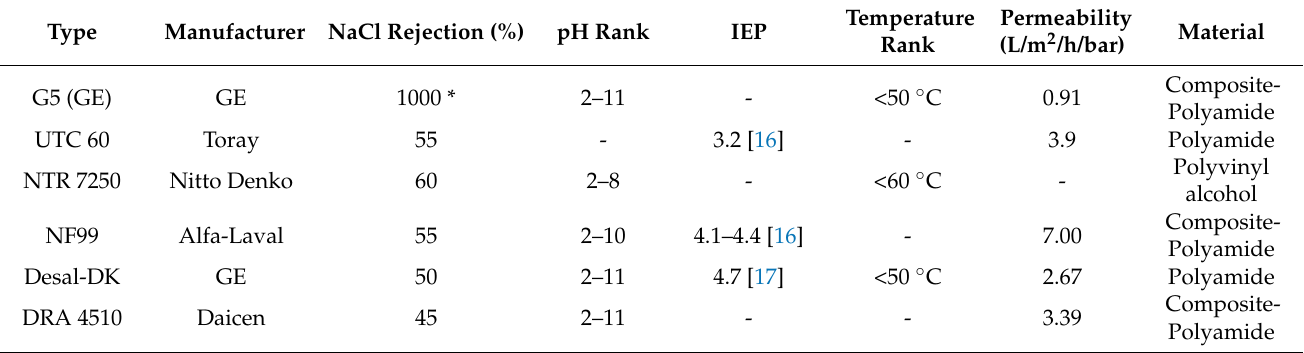
Table 1. Characteristics of membranes.